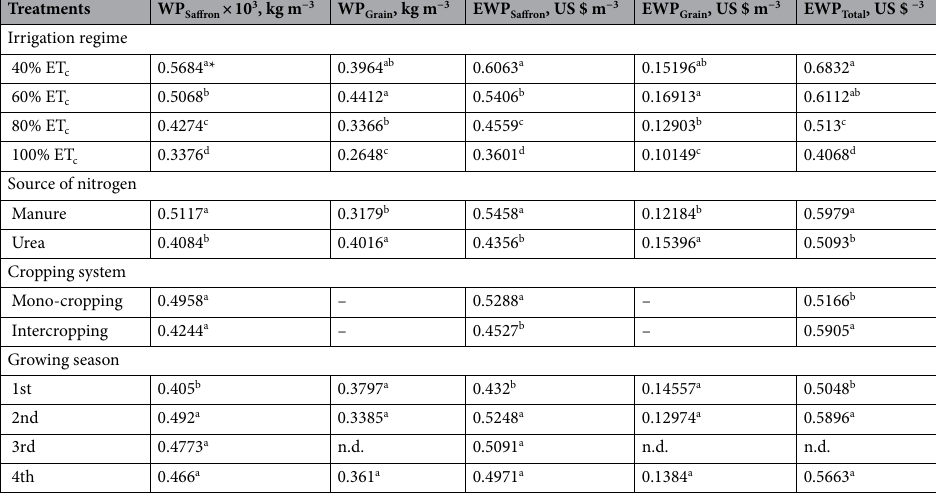
(Table 1) while the other growing seasons showed no significant difference regarding to this index. However, no significant difference was observed among the growing seasons in wheat grain IWP. Economic water productivity (EWP). Economic water productivity (EWP) indicates how much eco- nomic outcome is produced per cubic meter of water applied. It serves as a measure of the efficiency of the used water. The trend and pattern of changes in EWP for saffron and grain yields (Table S9 and Table 5) was similar to that of the IWP which just discussed in “Irrigation water productivity (IWP)”. The highest total EWP achieved in 40% ET c , and 60% ET c gained the second high rank. However, it decreased down significantly by an increase in the applied water depth. The total EWP of manure treatment was 17.0% greater than that of chemical source of nitrogen. Furthermore, intercropping showed a 14.0% higher value for total EWP which justifies the economic preference of saffron–wheat intercropping in comparison to saffron sole cropping. Furthermore, the effect of growing season on total EWP was significant and the first growing season experienced the lowest total EWP due to the lowest saffron yield (Table 1). However, there was not a significant difference between the second and last growing seasons according to total EWP.